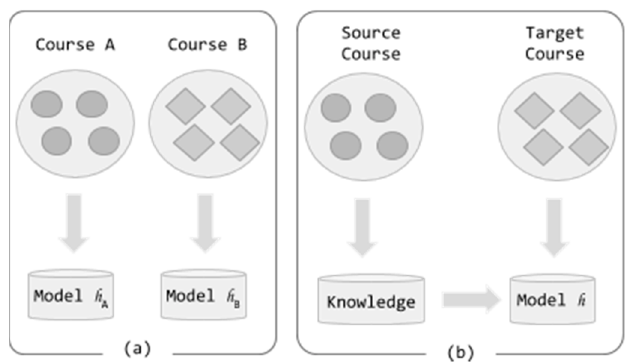
Figure 1. The traditional machine learning process ( a ), the transfer learning process ( b ).